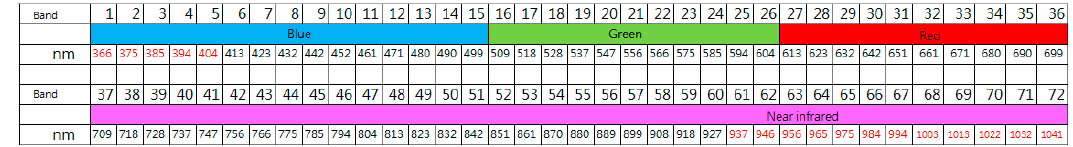
Figure 3. The hyperspectral corresponding image band of range.